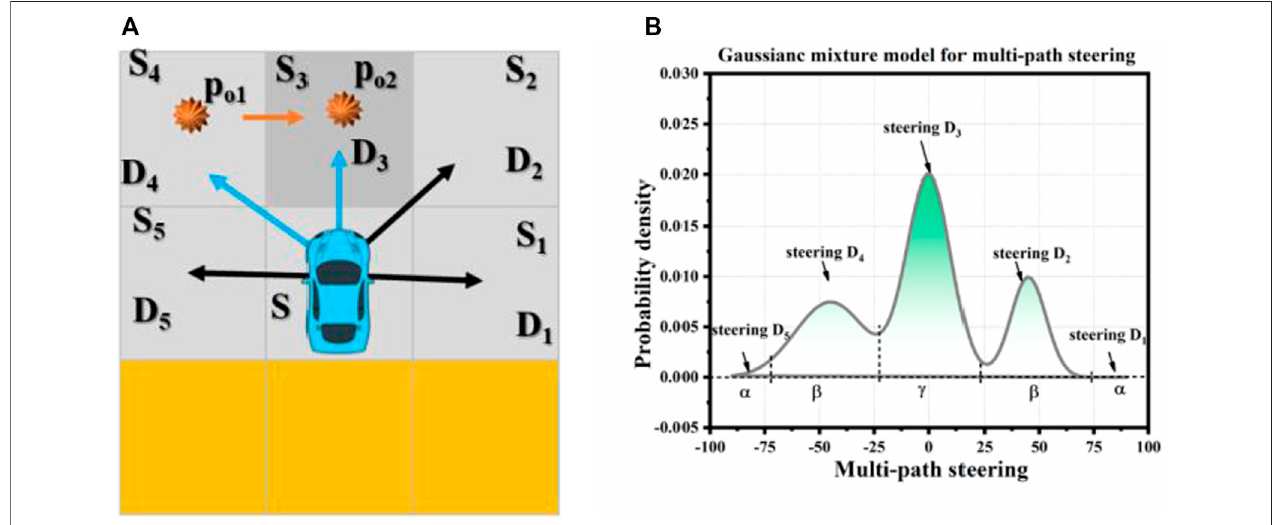
FIGURE22| Obstacleintrusionandoriginalsteeringdistributionofvehicles. (A) Expecteddrivingdirectionofvehiclesandpositionofobstacleintrusion. (B) Original steering distribution of vehicles.